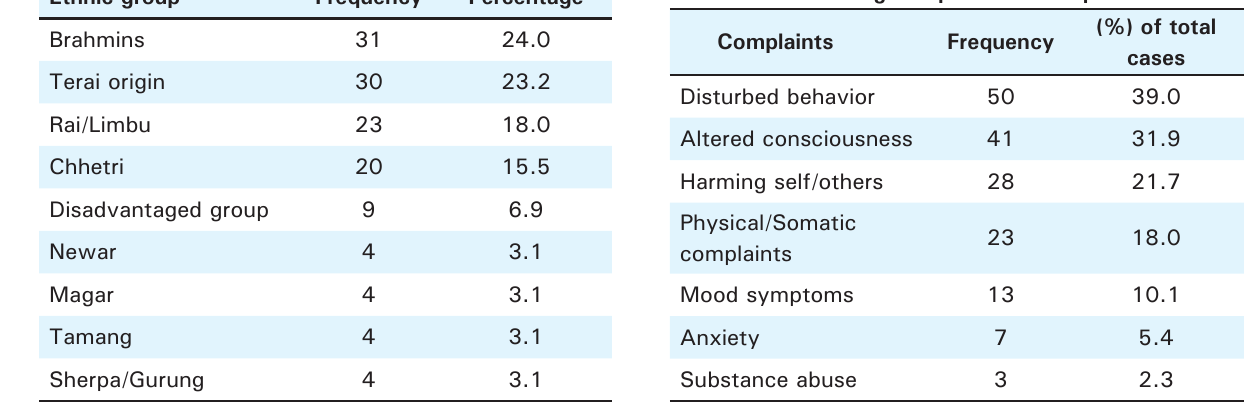
Table3a. Presenting complaints of the patients